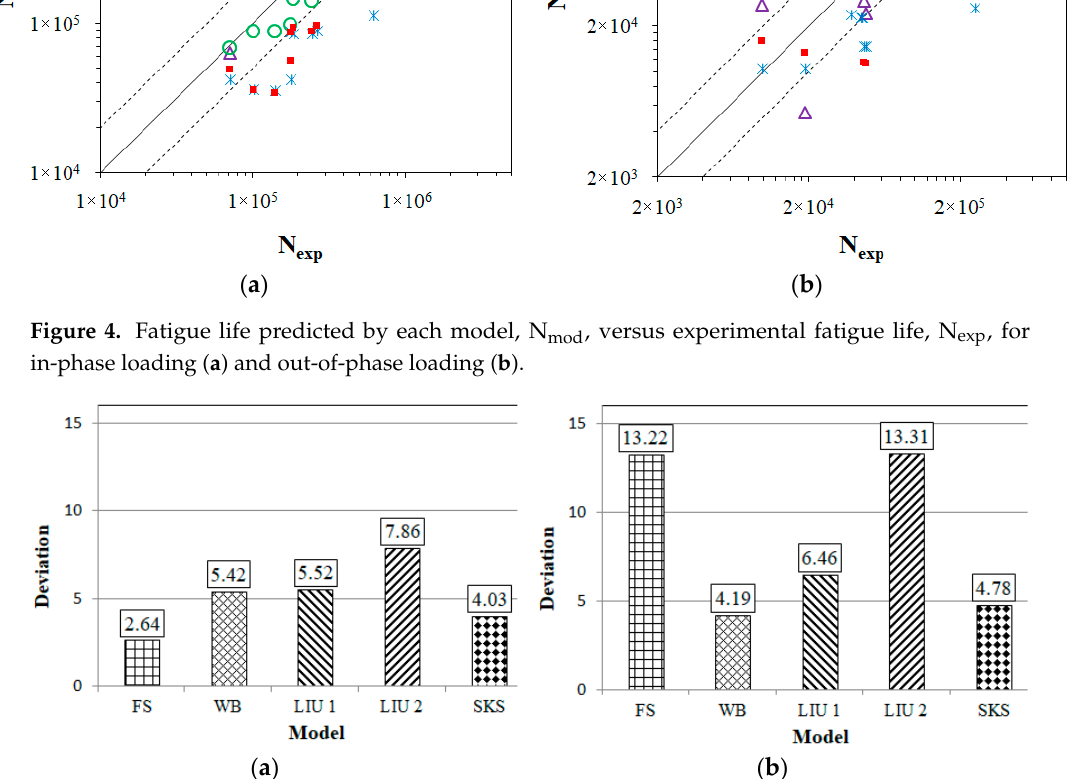
Figure 5. Fatigue life deviation for in-phase loading ( a ) and out-of-phase loading ( b ) for the five different critical plane models under study.